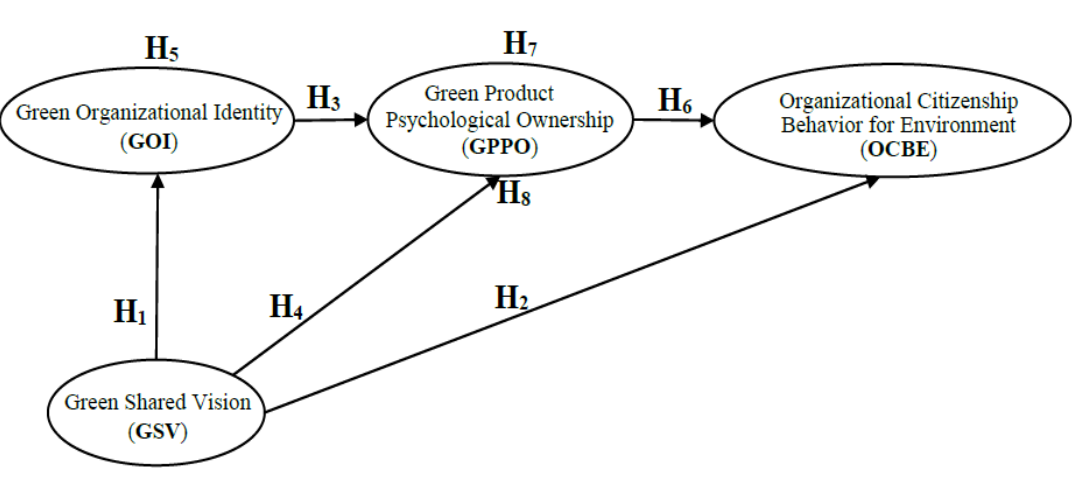
Figure 1. Research framework.